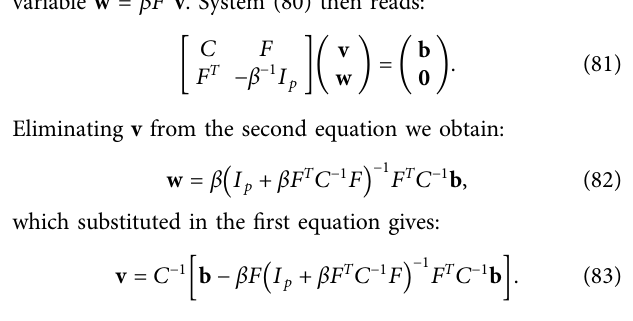
( Figure 2D ). More details on the model implementation and porous rock parameters are provided in Ferronato et